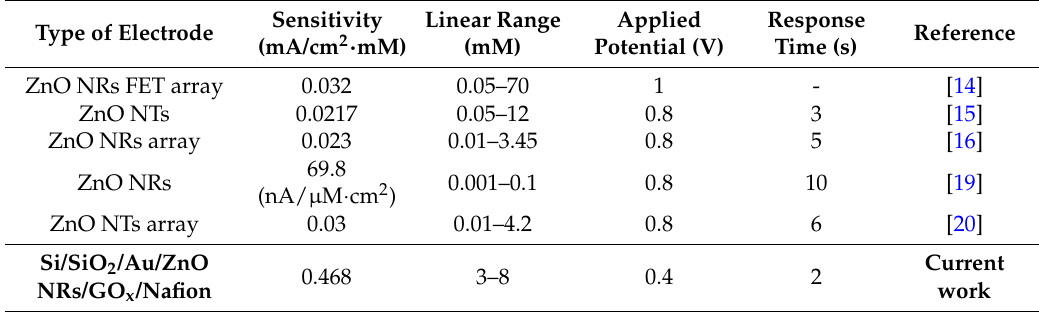
Table 1. The comparison between the current fabricated glucose sensor and other published sensors using differences in terms of sensitivity, applied oxidation-reduction potential, linear range, and the response